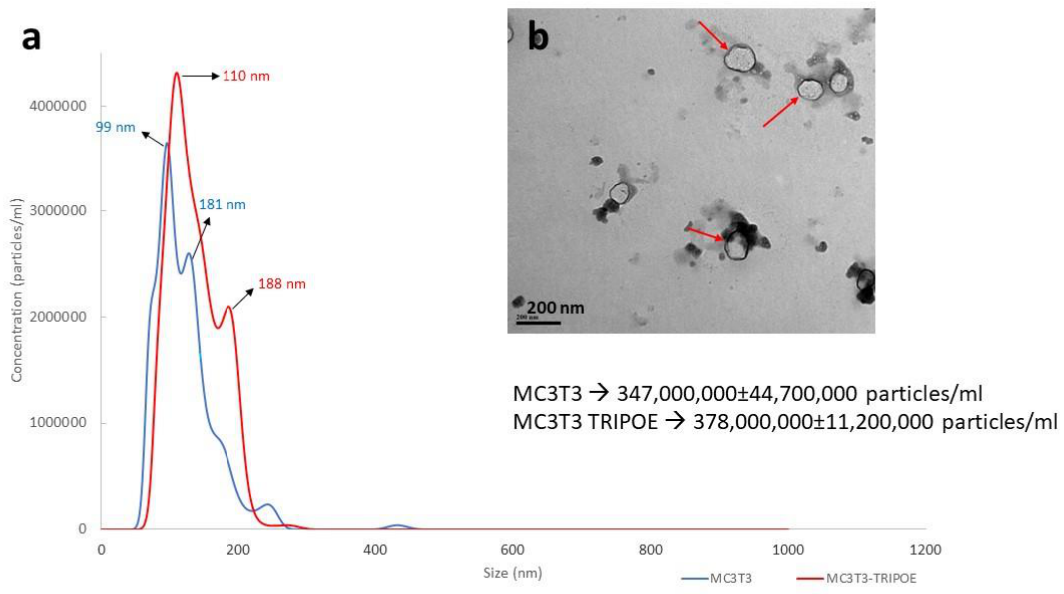
Figure 5. Characterization of the size and concentration of the purified matrix vesicles. ( a ) Nanopar- ticle Tracking Analysis showed the particle size distribution and concentration of MVs isolated from MC3T3 (blue) and TRIP-1OE (red) cells. X-axis denotes the size (nm) and Y-axis denotes the concentration of MVs (particles/mL). Particle size of MC3T3 MVs ranged from 99 to 181 nm and MC3T3-TRIP-1OE MVs ranged from 110 to 188 nm ( b ) Representative TEM image of MVs of TRIP-1OE cells. The size of the matrix vesicles ranged from 100–200 nm.